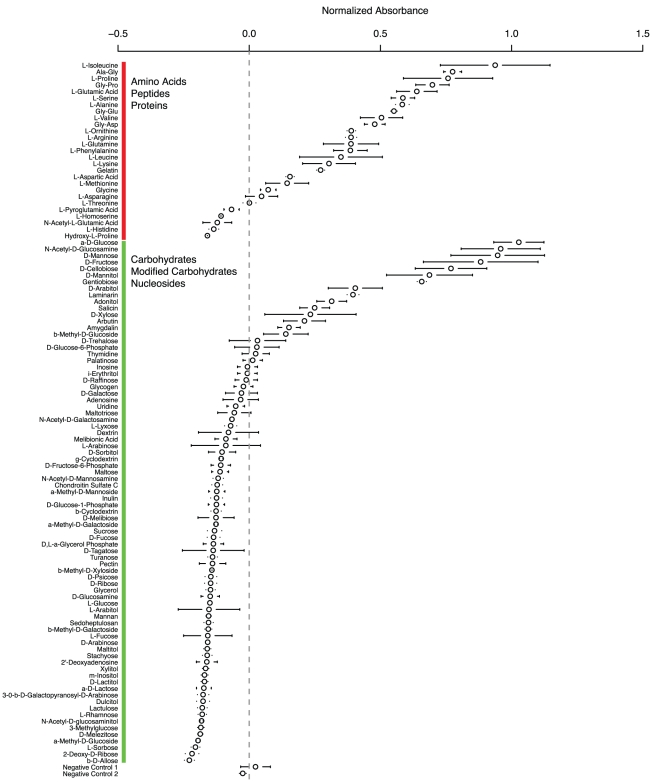
Growth by Uncinocarpus reesii on carbohydrates, amino acids, and peptides as the sole carbon source after a 7-day period.The experiment was done in triplicate; circles represent the normalized median absorbance at 590 nm and bars represent standard error. The dotted line indicates 0 normalized absorbance. Numerical growth values for all compounds can be found in Table S9.